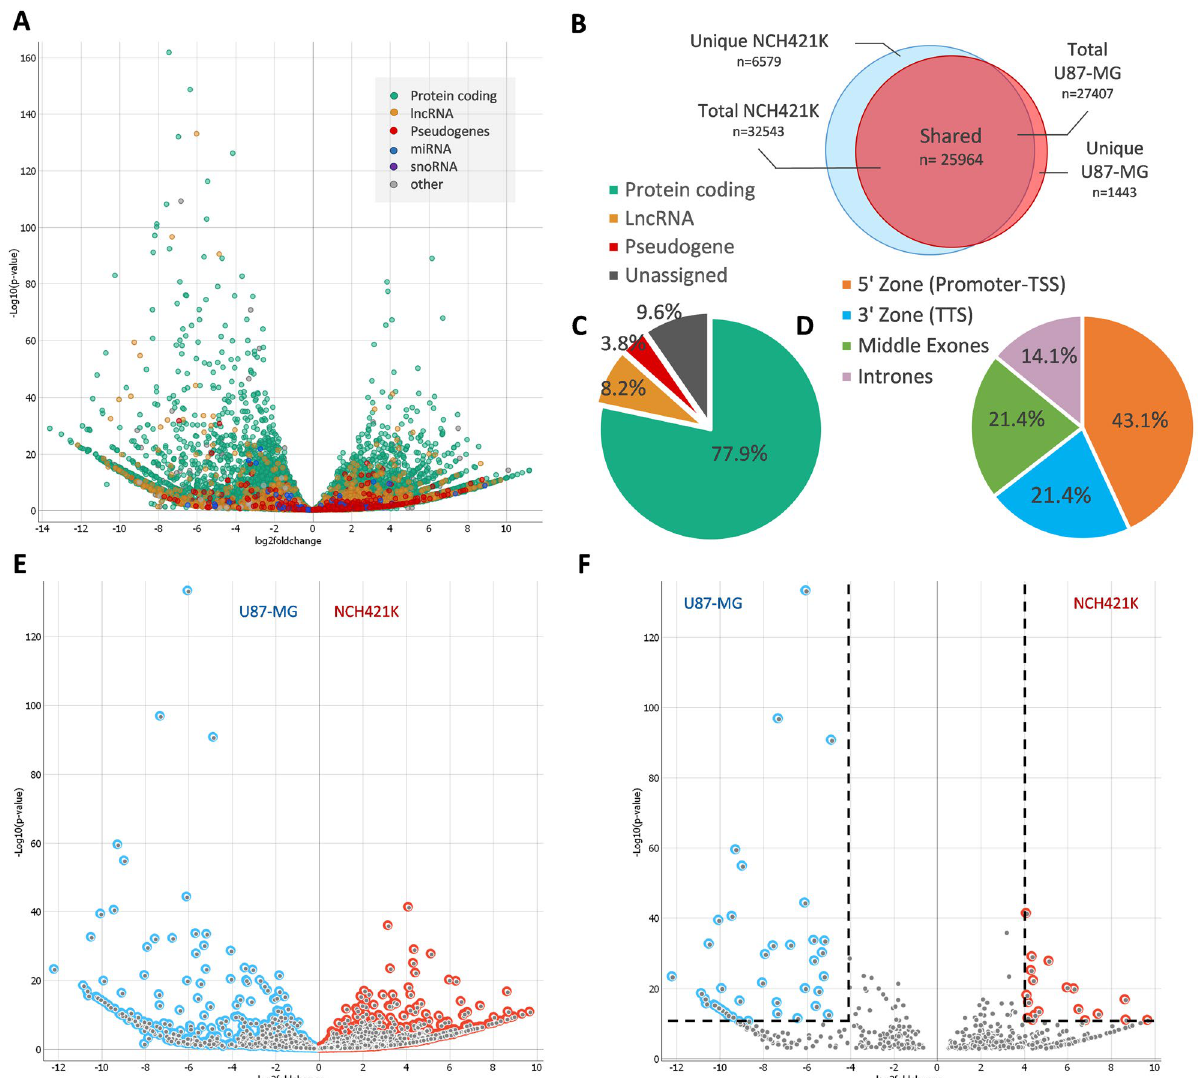
Figure 1. Distribution of MeRIP-seq data ( A ) Volcano-plot of detected m6A peaks in U87-MG (left) and NCH421K (right) cell lines applying MeRIP-seq. ( B ) Venn-diagram of detected cell line specific and common m6A peaks after MeRIP-seq. ( C ) The percentage of detected m6A peaks by annotation type. ( D ) Pie chart of the percentage of detected m6A peaks in lncRNA transcripts (n = 659) by peak localization. ( E ) Volcano-plot of all detected lncRNA m6A peaks. ( F ) Volcano-plot of differentially modified lncRNAs m6A peaks between U87-MG and NCH421K cell lines after FDR, log 2 FC and p-value cut-off. Dot-lines indicate the selected threshold of p-value < 1 × 10 −10 (y-axis) and selected threshold of log 2 FC ≥ 4 (16-fold) (x-axis); blue and red colored dots respectively indicate U87-MG and NCH421K specific lncRNA m6A peaks that were selected for the further analysis.